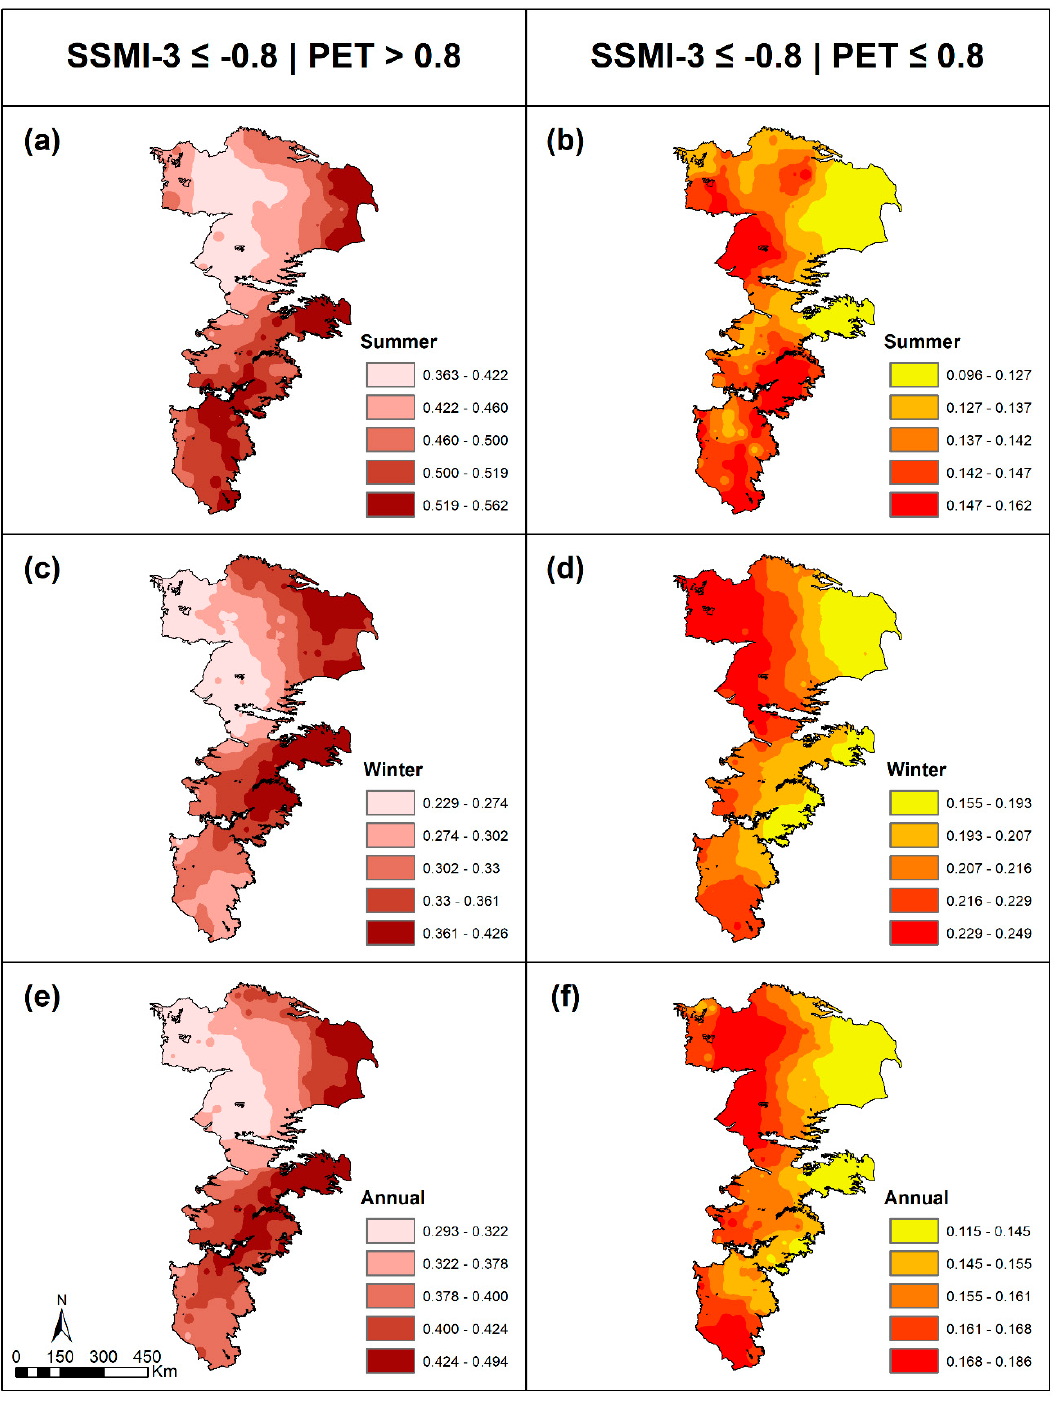
Figure 8. SSMI3 risks of moderate or higher agricultural droughts under standardized PET being at moderate or higher (left panel) and lower than moderate (right panel) conditions ( a – f ).